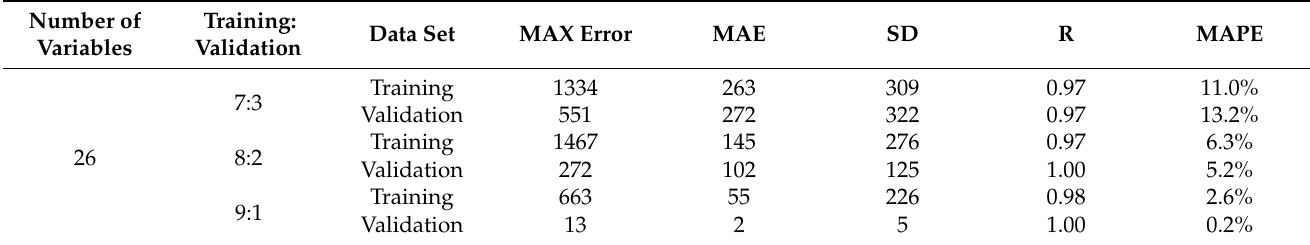
Table A12. Analysis of the results of the BPNN model for natural gas